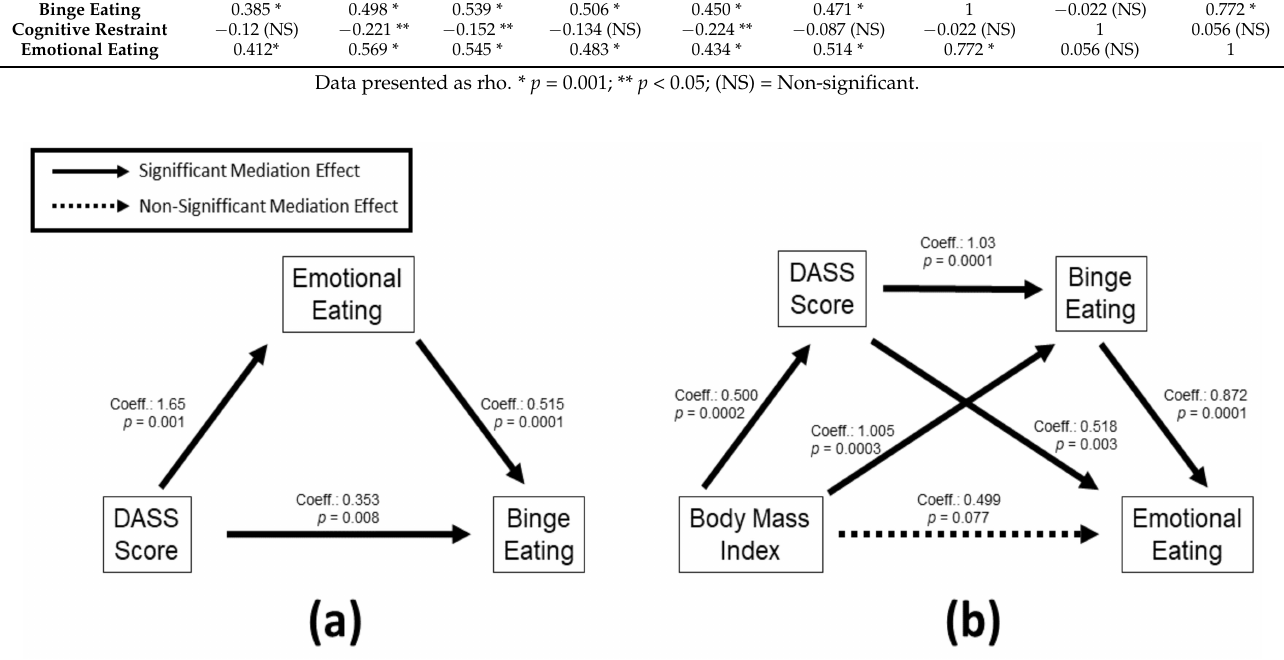
Figure 1. Mediation Analyses: ( a ) Model 1 considers the effect of the DASS score on binge eating behavior and identifies the mediation effect of emotional eating; ( b ) Model 2 identifies no significant effect of body mass index on emotional eating, albeit body mass index exerts effects on the DASS score and on binge eating behavior, both of which present mediation effects on emotional